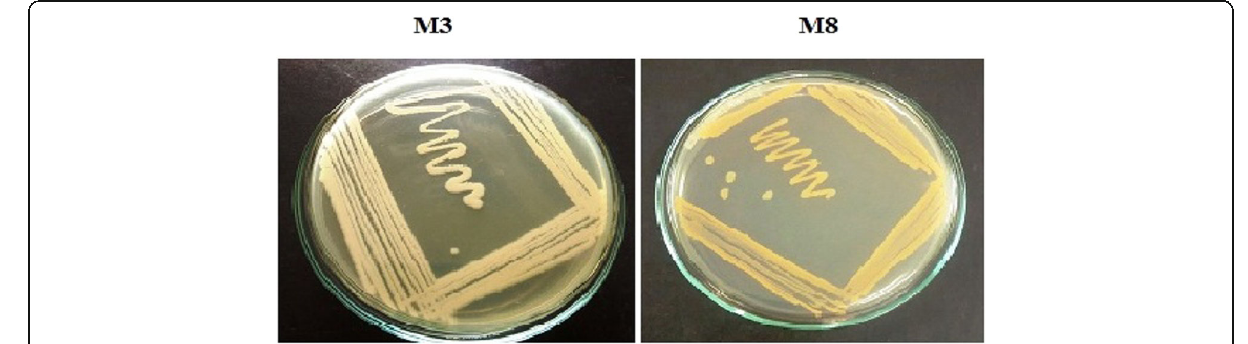
Fig. 1 M3 — Bacillus subtilis , M8 — Pseudomonas